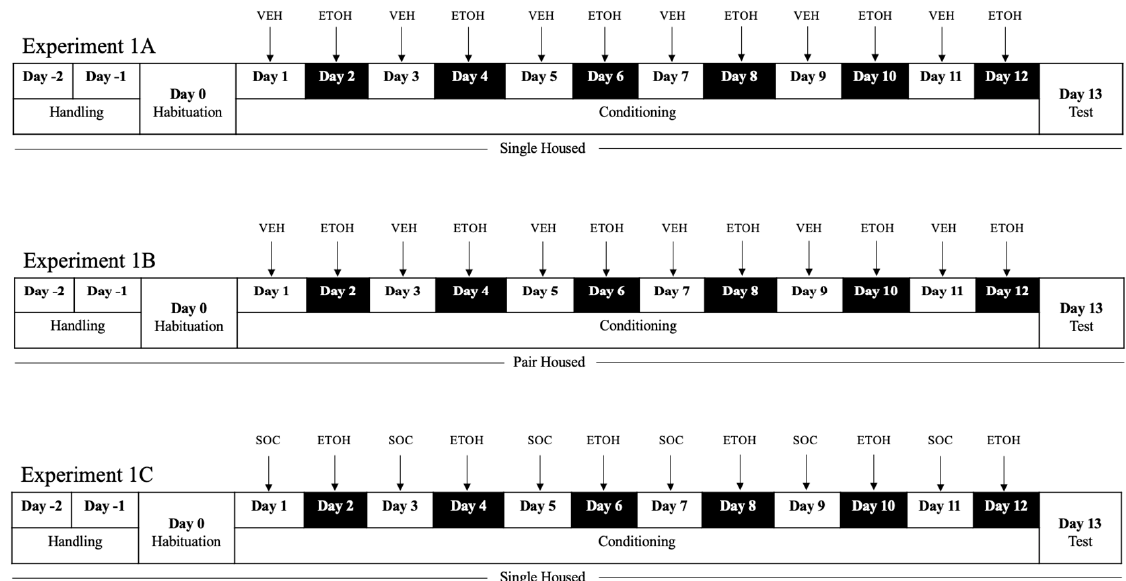
Figure 1. Experimental timeline and manipulation in ( A ) experiment 1A, ( B ) experiment 1B, ( C ) experiment 1C. Ethanol-conditioning vs. saline or social-paired sessions were counterbalanced in all experiments for day and context. During conditioning, all rats received alternating conditioning trials in separate contexts. ETOH = ethanol; VEH = vehicle; SOC = social Interaction.